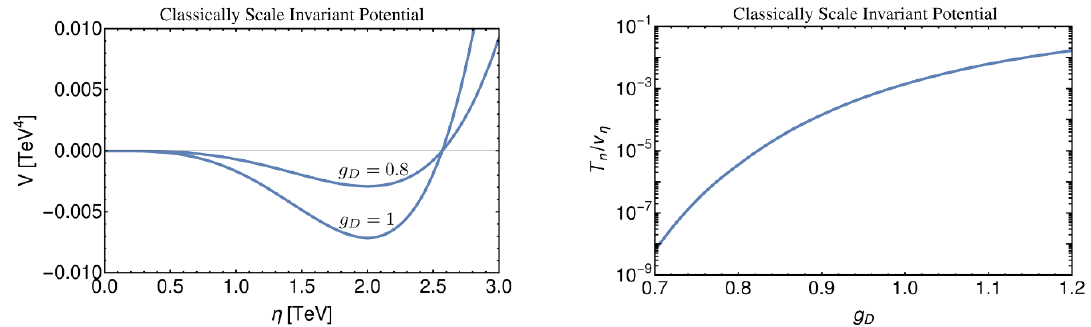
Figure 6 . Left: the classically scale invariant potential ( T = 0) with v (cid:17) = 2 TeV and two choices of the gauge coupling. Right: the nucleation temperature as a function of the gauge coupling in the classically scale invariant case, for a (cid:12)xed nucleation condition S 3 =T = 142, and ignoring QCD